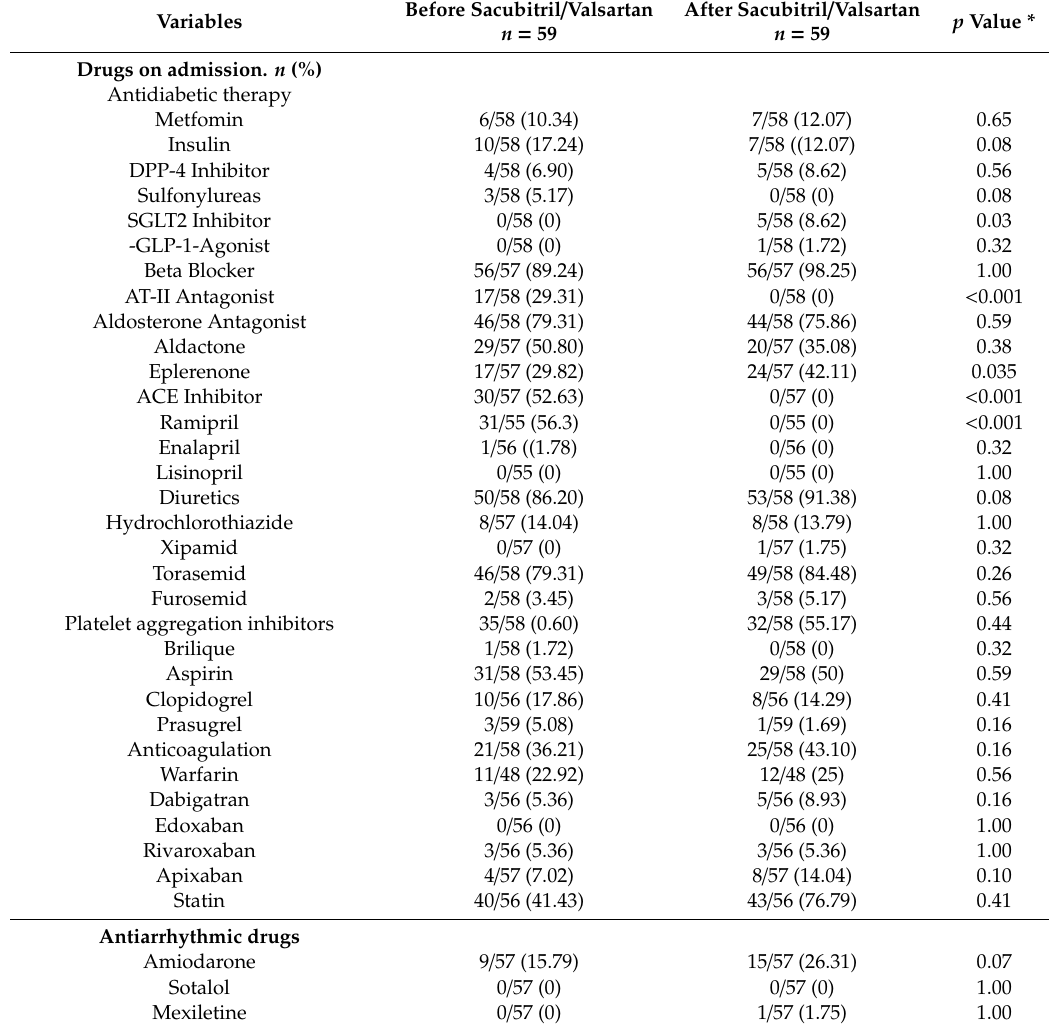
Table 4. Treatment of 59 patients before and after initiation of sacubitril / valsartan.